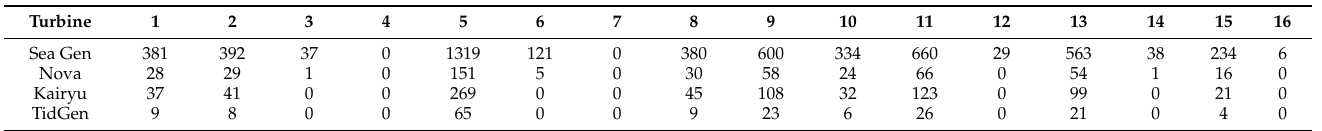
Table 3. Theoretical energy extracted in 1 year per turbine, at − 30 to − 50 m depth, per node and per device in MWh/year using Equation